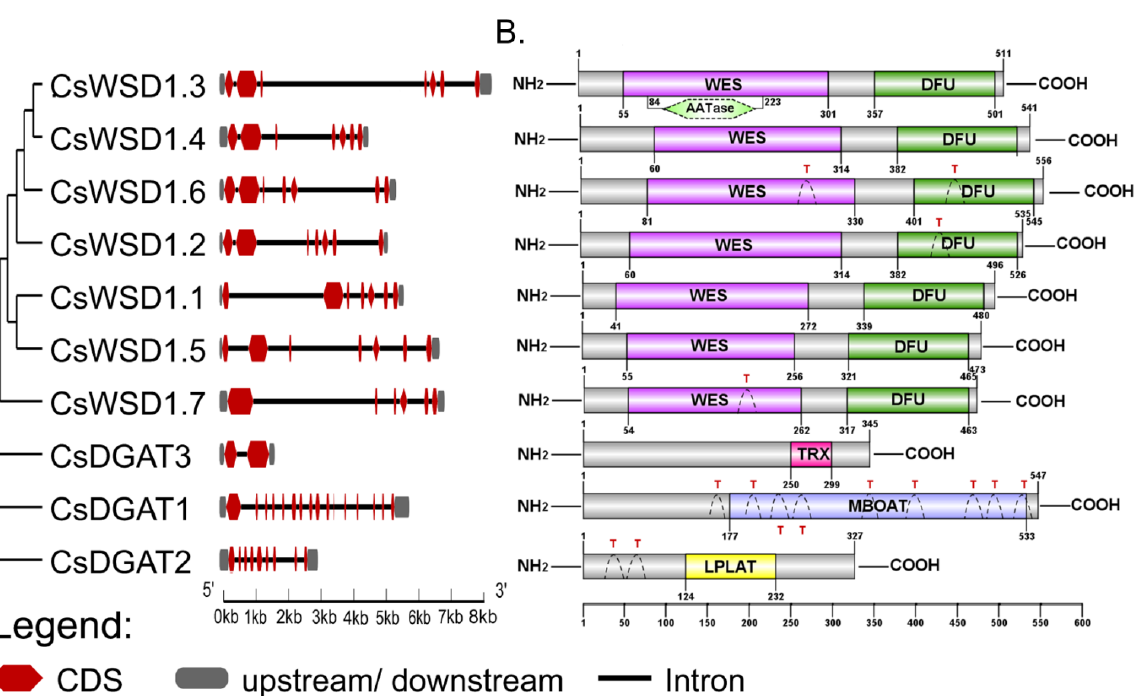
Figure 3. Structures for the CsDGAT gene family. ( A ) Phylogenetic relationships and gene structures for the CsDGAT gene family. Phylogenetic tree generated by the neighbor-joining tree method with bootstrapping analysis (1000 replicates) based on the protein sequences of CsDGAT. The exon-intron structures for CsDGAT gene family members were visualized with GSDS2.0. The horizontal black lines, red boxes, and gray boxes show introns, coding sequence, and untranslated region, and the scale displays the relative length and position of the introns and exons. ( B ) Model illustrating transmembrane regions and putative conserved domain structure of 10 CsDGAT protein identified in C. sativa . The CsDGAT family can be divided into three subgroups based on the different conserved domains: CsDGAT1, CsDGAT2, CsDGAT3, and CsWSD1. The grey bars represent the length of each protein sequence, and conserved domains are shown as colored boxes. The conserved domain architectures prediction relies on SMART, and IBS software was used for visualization with default parameters. MBOAT = membrane-bound O-acyl transferase domain, LPAT = lysophospholipid acyltransferase domain, TRX = thioredoxin-like, ferredoxin family domain, WES = wax ester synthase-like Acyl-CoA acyltransferase domain, DUF = domain of unknown function, AATase = alcohol acetyltransferase domain, T: transmembrane domains; The numbered bar indicates the position of amino acid.